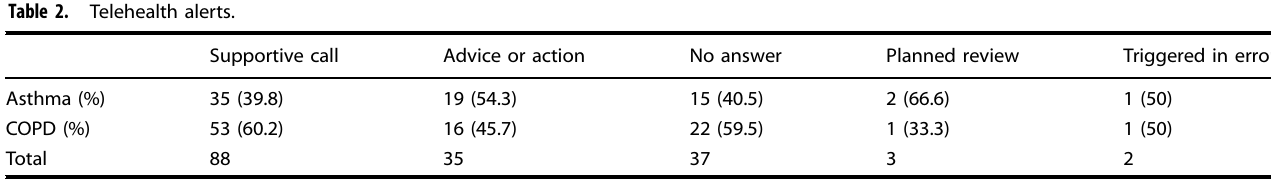
Table 2. Telehealth